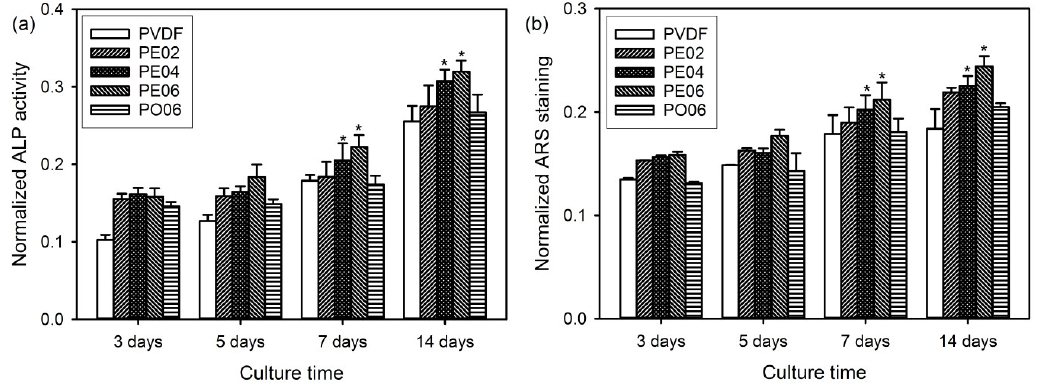
Figure 10. ( a ) ALP activity and ( b ) quantitative calcium deposition of MC3T3-E1 cells on the PVDF composite nanofibers after culturing for 3, 5, 7, and 14 days ( n = 6). The values of ALP activity and